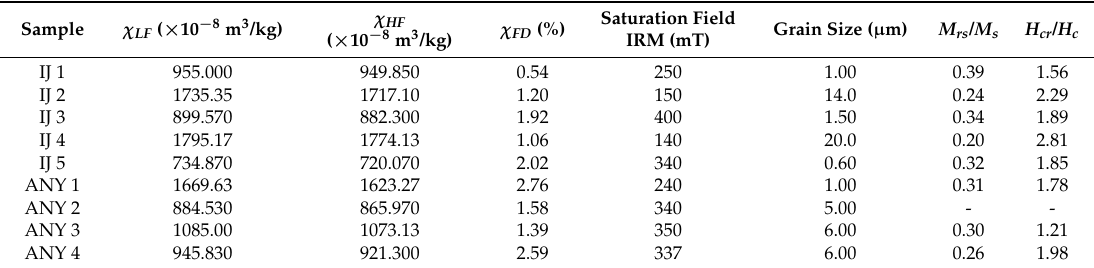
Figure 5. The thermomagnetic curve of ( a ) IJ 2; ( b ) IJ 3; ( c ) IJ 5; and ( d ) ANY 3. Tc : Curie Temperature. Table 2. Rock magnetic data of all